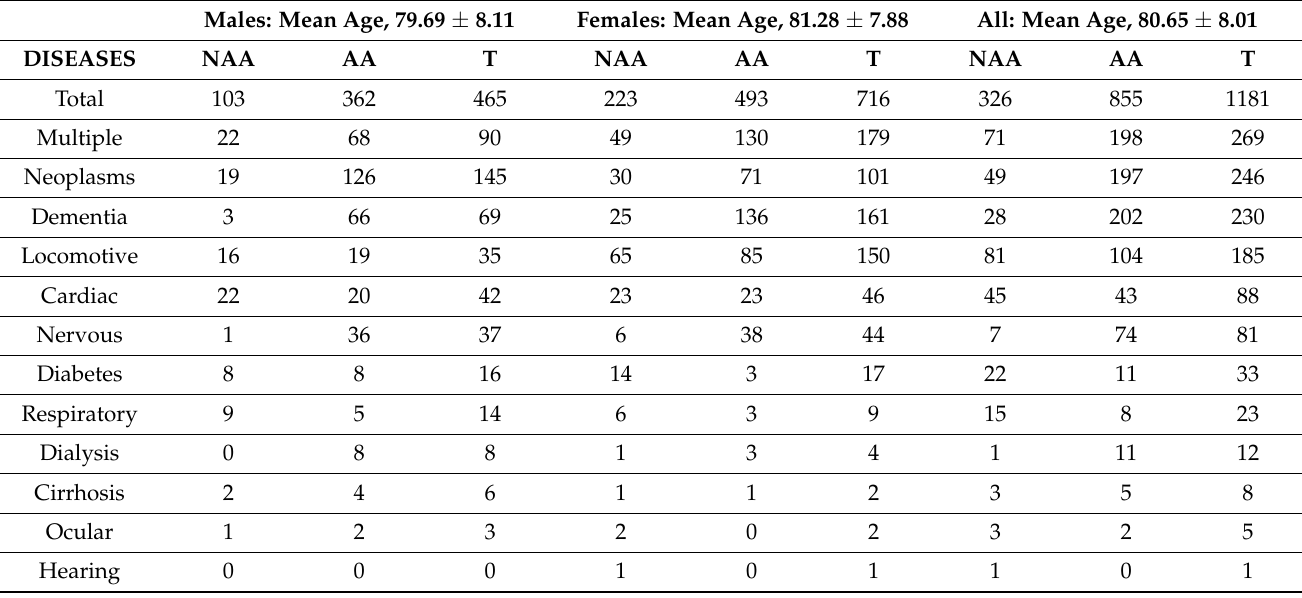
Table 7. Iglesias: civil invalidity in subjects over 65 years old in 2021 (January–September). Males: Mean Age, 79.69 ± 8.11